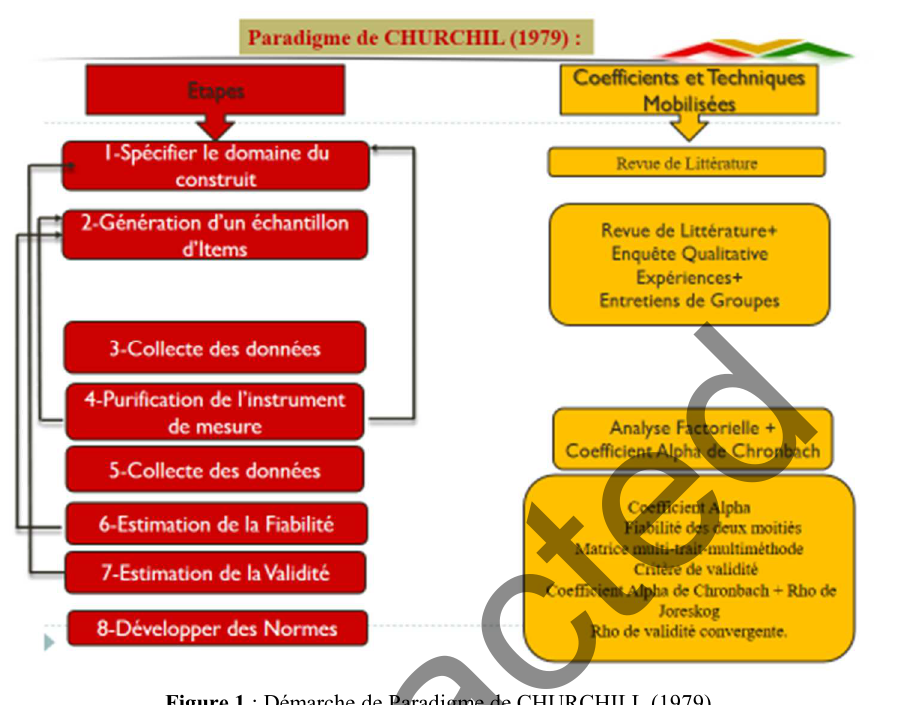
Figure 1 : Démarche de Paradigme de CHURCHILL